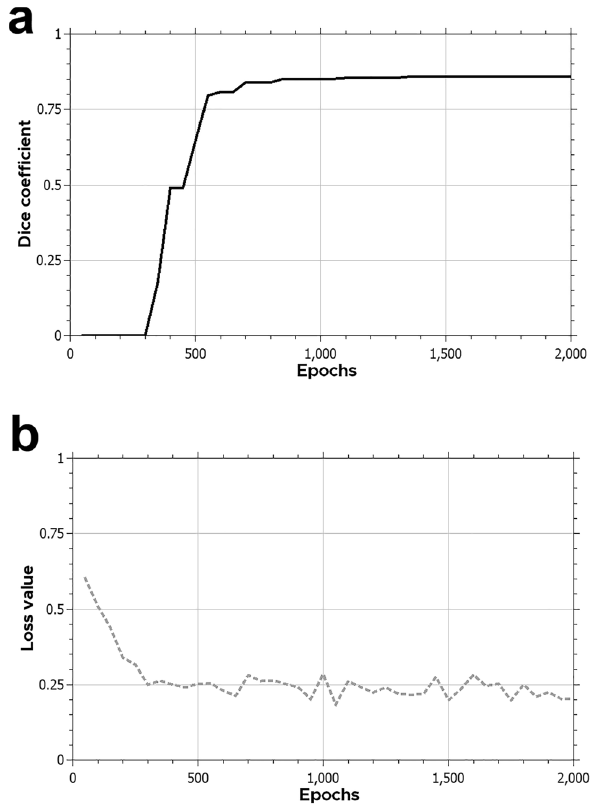
Figure 3. Training Dice similarity coefficient ( a ) and loss ( b ) for the inner ear training. The DSC graph demonstrates the improvement and eventual optimization of the model and the minimization of the loss function.